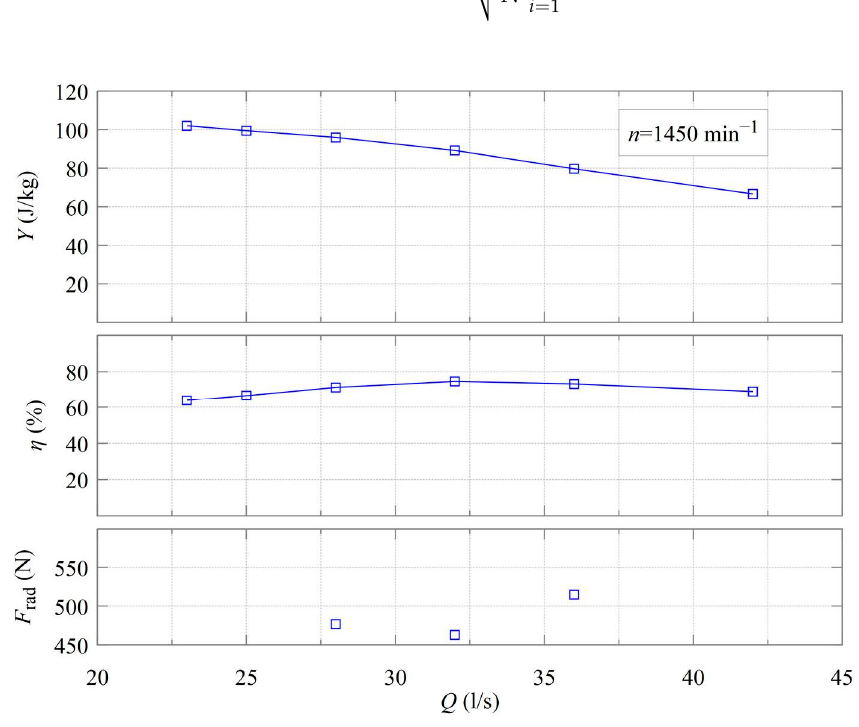
Figure 4. Pump performance curves and radial force waveform (calculate and prediction).